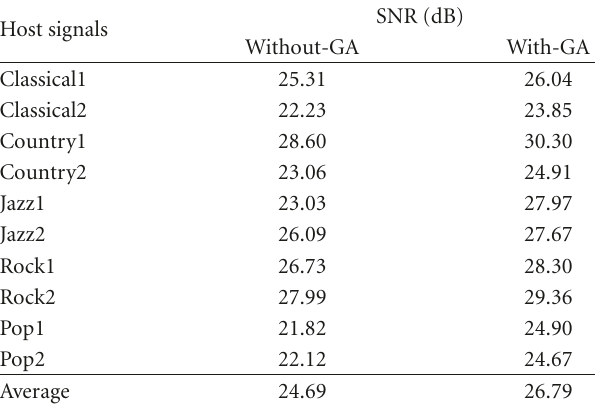
Table 4: Signal-to-noise ratio of watermarked audio